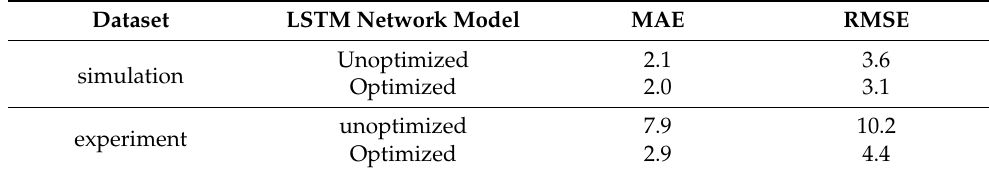
Table 1. The MAE and RMSE of models on the simulation and experiment results (Unit: mm).